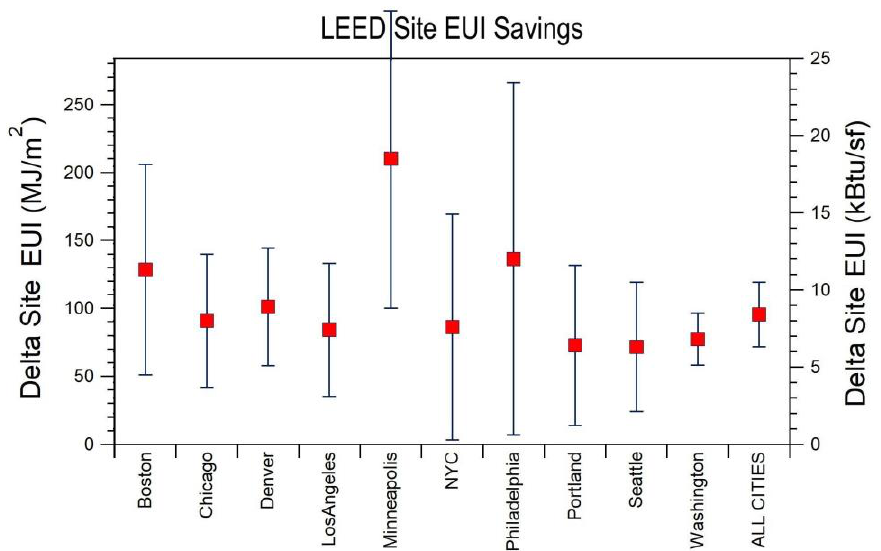
Figure 3. Area-weighted mean LEED site EUI savings (as compared with non-LEED offices in the same city). Error bars represent bootstrap standard deviations (1 sigma) of the mean deltas (or differences).